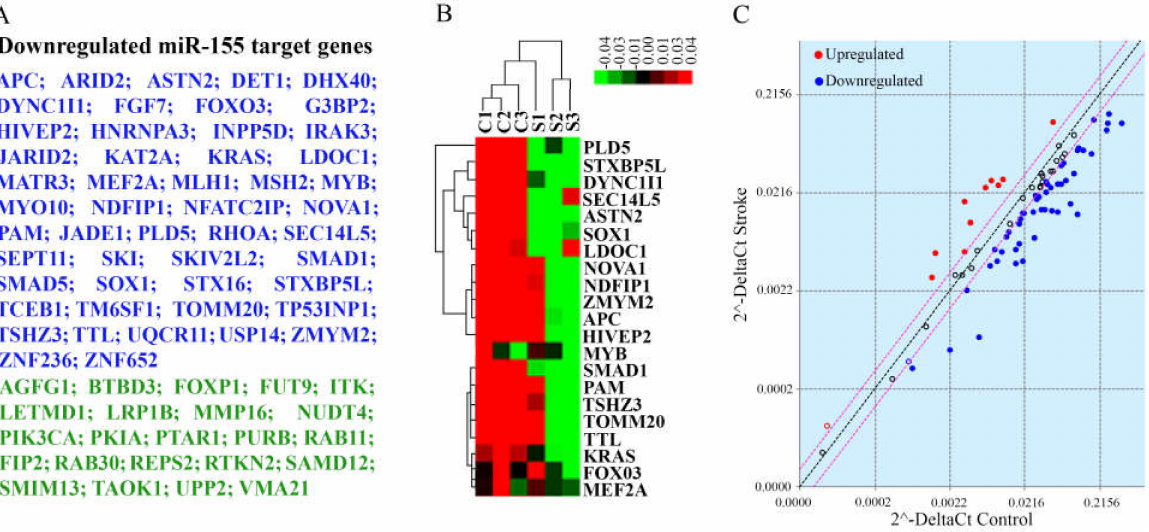
Figure 6. miR-155 target gene analysis. ( A ) A list of miR-155 direct target genes significantly downregulated in stroke tissue, compared to control samples. Blue—genes identified by PCR Array, green—additional genes identified by whole transcriptome sequencing. ( B ) A portion of a heatmap (after non-hierarchical clustering) displays a group of target genes with significantly lower (green) expression in the stroke samples. The heat map was generated based on delta Ct values. Genes with higher expression levels are shown in red, whereas genes with lower expression levels are shown in green. Genes with average expression levels are shown in black. ( C ) Scatter plot compares the normalized gene expression between the stroke and control samples. The central line indicates unchanged gene expression. Red circles identify genes significantly upregulated in stroke tissue, blue—genes significantly downregulated in stroke group. The graph plots the log10 of normalized gene expression levels in control samples (x-axis) versus stroke samples (y-axis). N = 3 samples per control and stroke